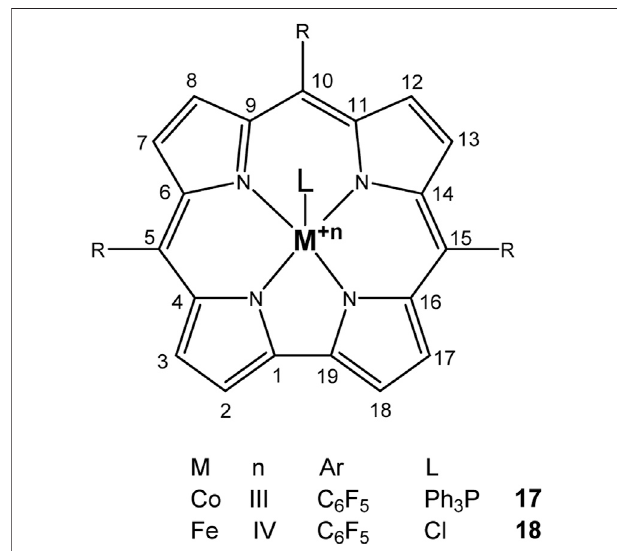
FIGURE 8 | Immobilization of CoPc catalysts on P4VP (Kramer and McCrory,